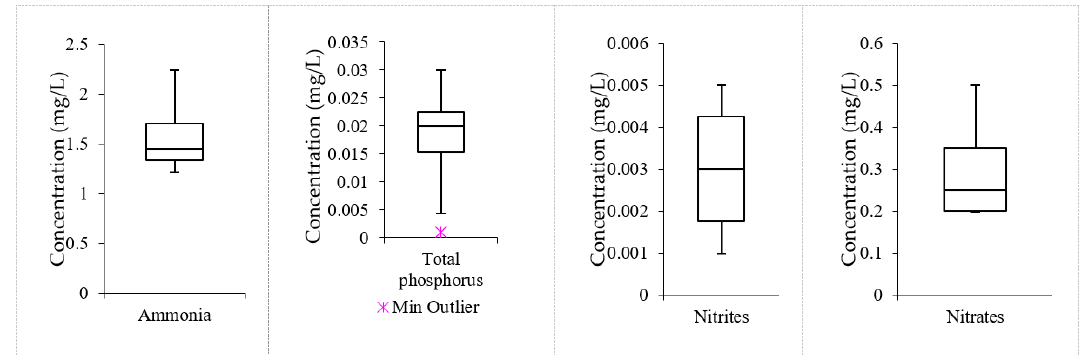
Figure 5. Integrated treatment.